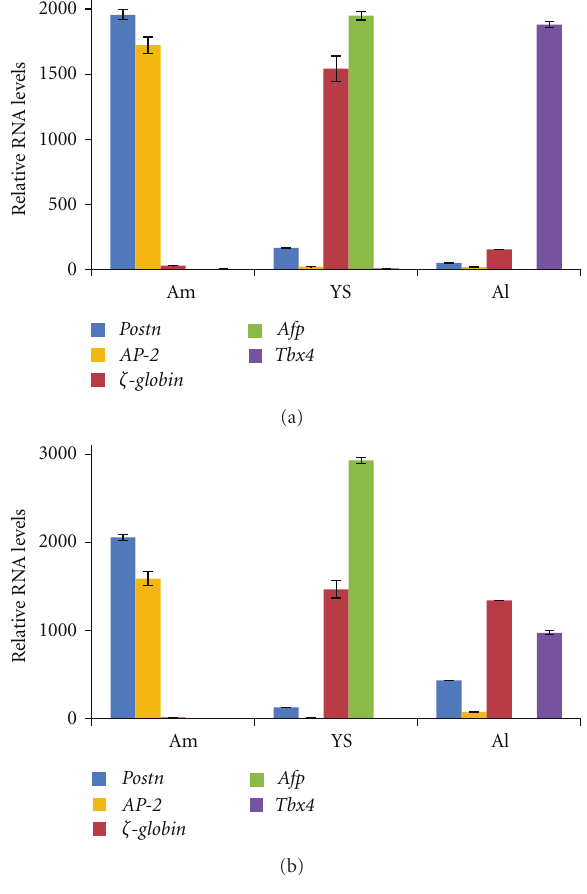
Figure 5: Relative RNA expression of Postn, AP-2, ζ -globin, Afp, and Tbx4 in extraembryonic tissues of (a) E8.5 and (b) E9.5 mouse embryos. Here, the relative RNA expression values were multiplied or divided by a scale factor, in order to represent values for di ff erent transcripts with di ff erent expression levels in a single graph. Expression levels of the di ff erent genes cannot be compared. Amnion is enriched in Postn and AP-2 , while visceral yolk sac ( Afp ), allantois ( Tbx4), and primitive red blood cell ( ζ -globin ) markers are neglectable. In contrast, yolk sac and allantois express low levels of Postn and AP-2. Abbreviations: Am: amnion; Al: allantois; YS: